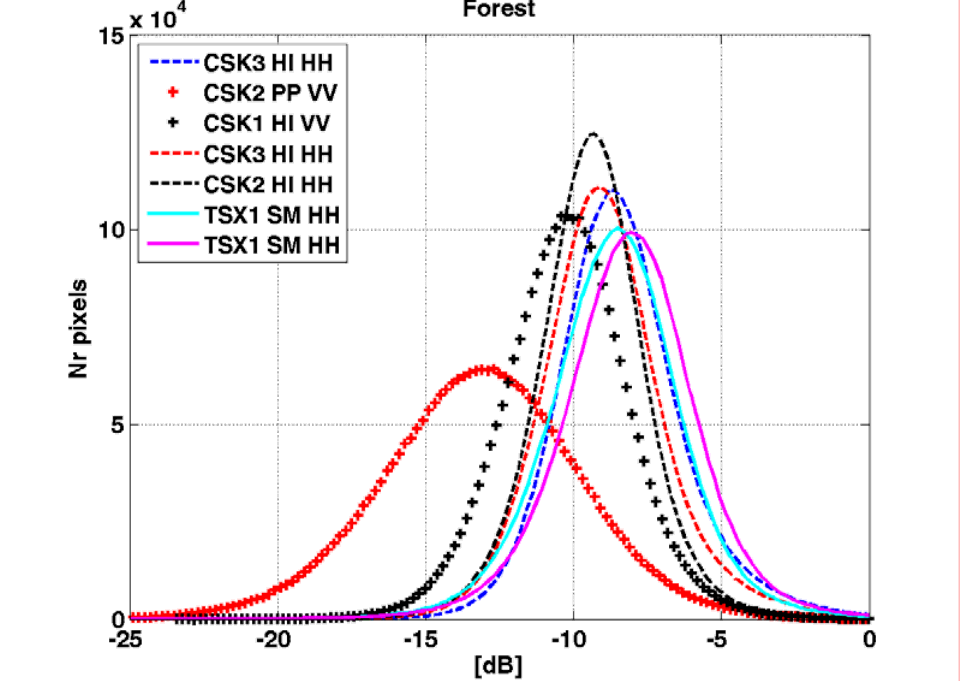
Figure 4. Histogram of σ ° from COSMO-SkyMed (CSK) and TerraSAR-X (TSX) satellites over a forest area.